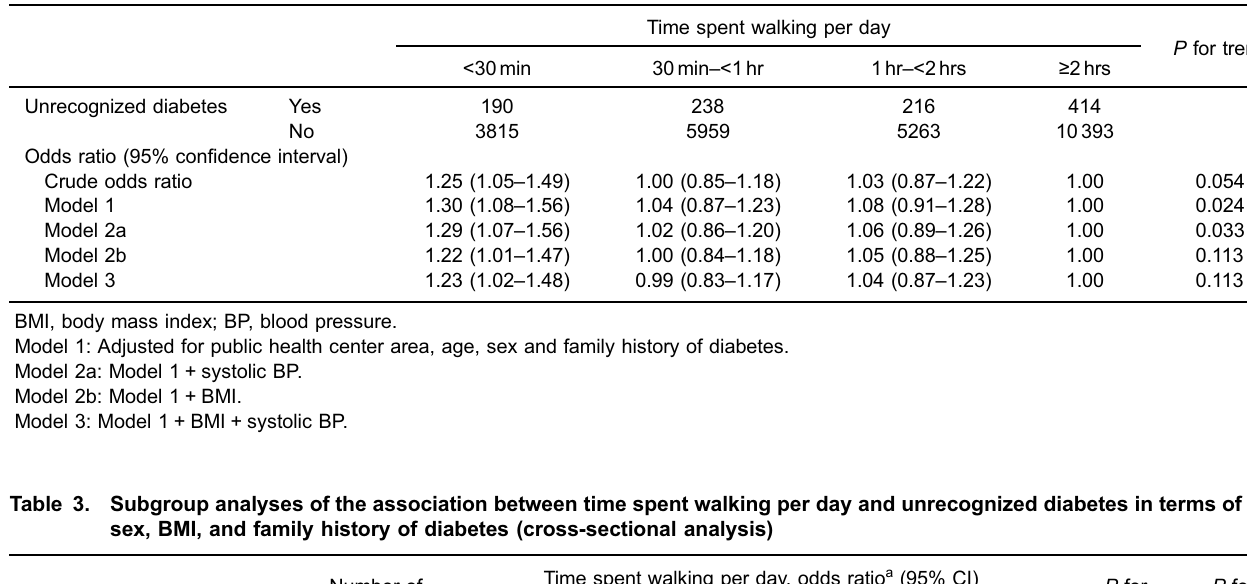
Table 2. Time spent walking per day and unrecognized diabetes (cross-sectional analysis)